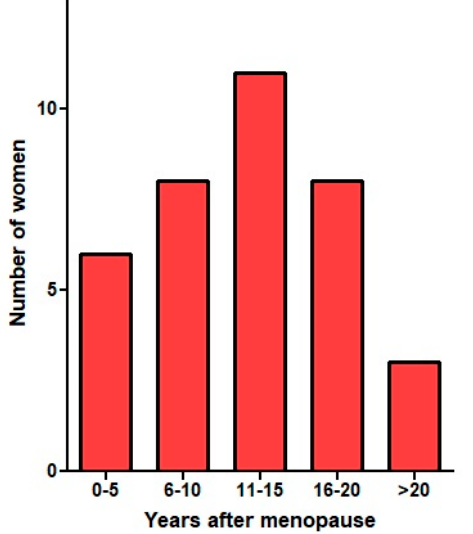
Figure 1. Deep endometriosis initiating more than 10 years after menopause in women not taking estrogens (reprinted from [11] with permission) suggests monitoring the growth of endometriosis during medical